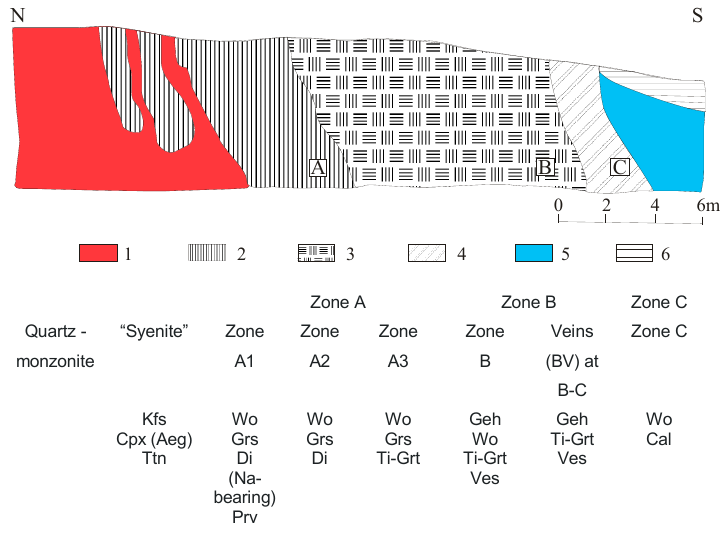
Figure 2. Geological cut of the high-temperature skarn outcrop on the upper Cerboaia Valley (redrawn from [5]). Symbols represent: 1—Quartz monzonite; 2—A zone (gehlenite + vesuvianite + garnet); 3—B zone (garnet + gehlenite + wollastonite); 4—C zone (wollastonite + garnet); 5—Limestone; 6—Diopside hornfels. The mineralogical zoning in the skarn from M ă gureaua Va¸tei as given by [4] is presented on the bottom. Abbreviations represent: Kfs = alkali feldspar; Cpx (Aeg) = clinopyroxene (aegirine); Ttn = (titanite); Wo = wollastonite; Grs = grossular; Di = diopside; Prv = perovskite; Ti-Grt = titanian garnet; Geh = gehlenite; Ves = vesuvianite; Cal =